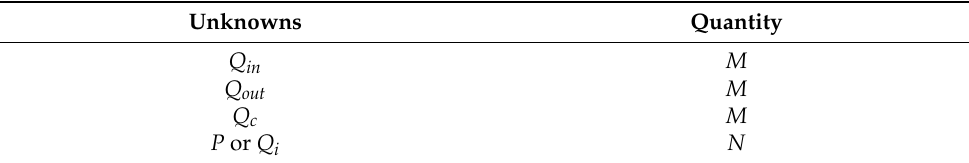
Table 3. Unknowns of an N -node and M -branch steam heating network.